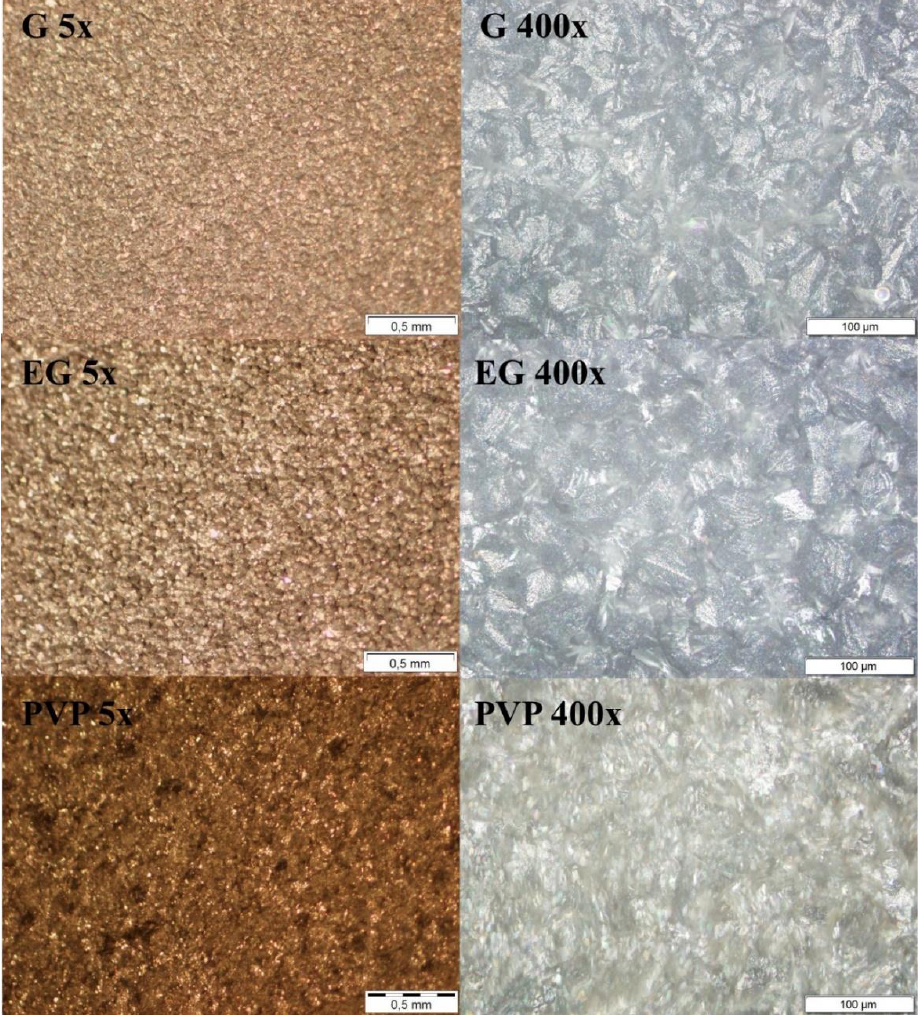
Figure 9 . Metallographic microscopic images of lead electrodeposited at 60 °C using different inhib- Figure 9. Metallographic microscopic images of lead electrodeposited at 60 ◦ C using different itors .